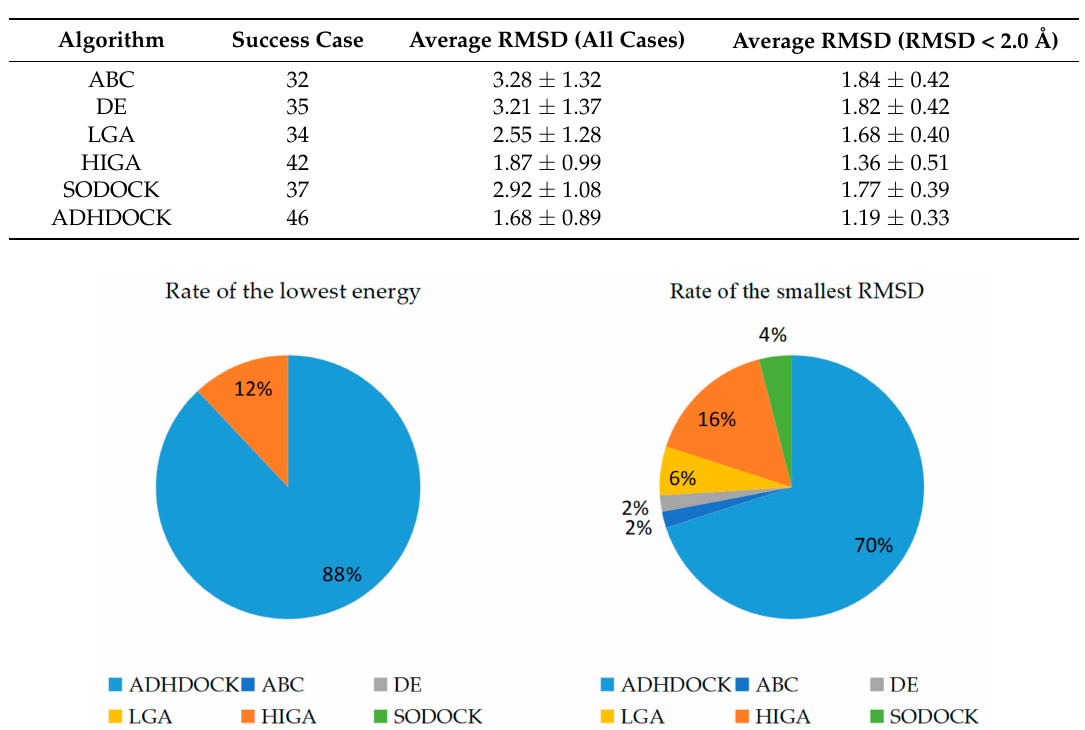
Table 2. root-mean-square deviation (RMSD) results of the first predicted conformations.